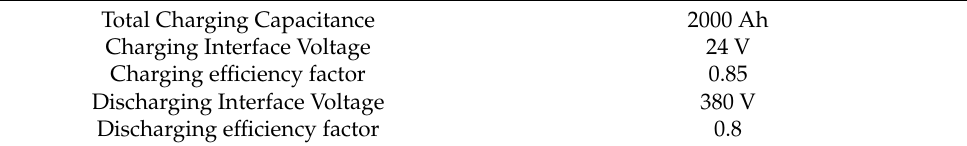
Table 7. Technical Data of Batteries Storage